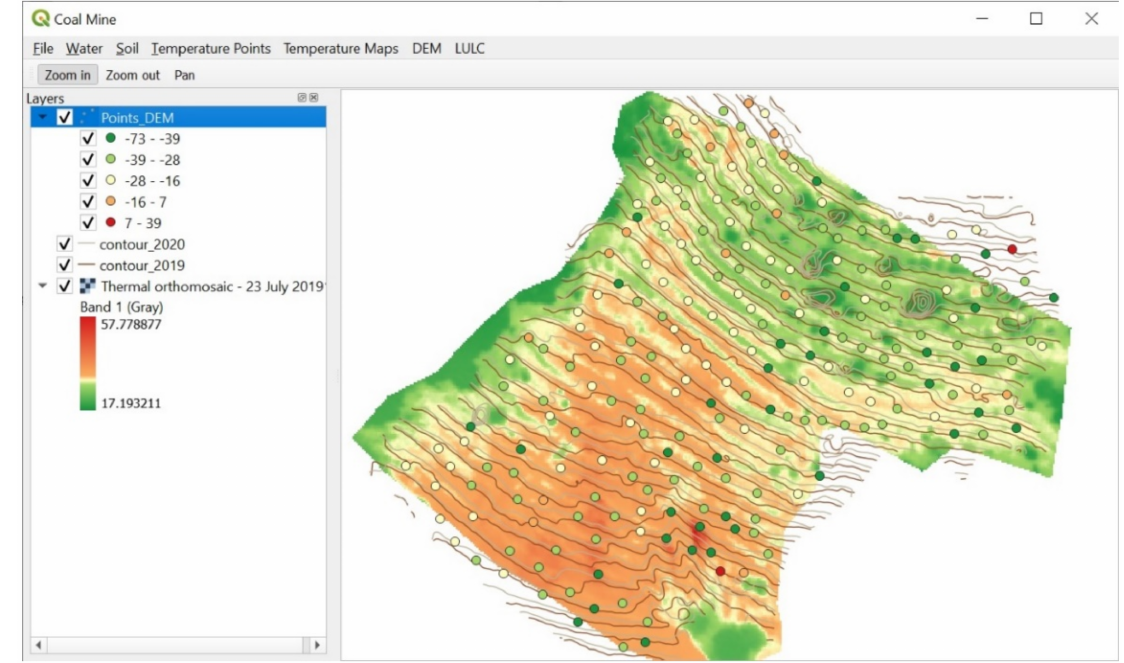
Figure 14. Coal Mine application with overlapped information (raster and vector formats) of the waste pile: thermic orthomosaic, points with DEM values differences, contour from 2019 and contour from